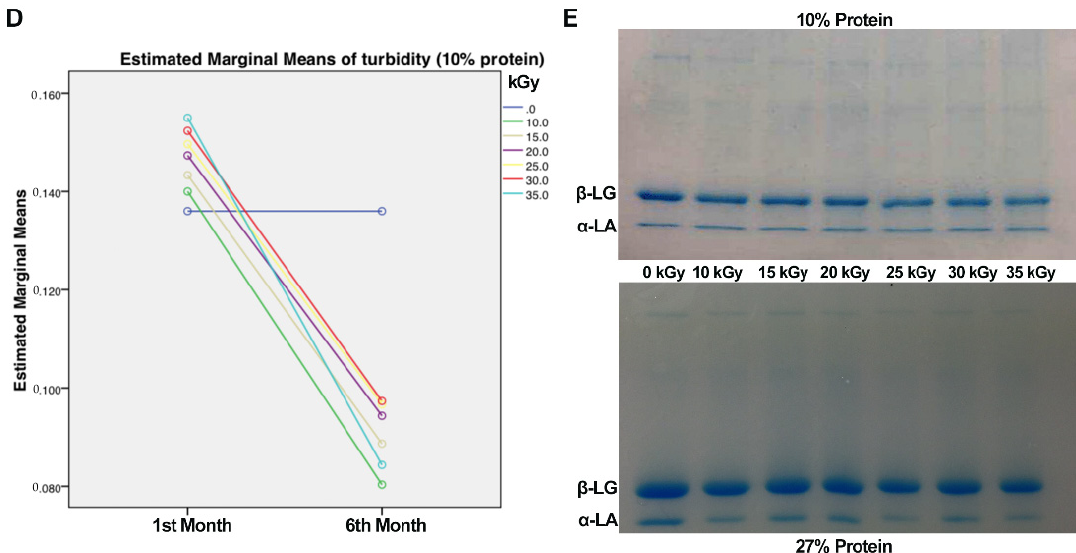
Figure 2. Effects of gamma radiation on property changes of WPI solutions (10% protein). ( A ) Effect of gamma radiation on soluble nitrogen of WPI solution (10%) in the first month after gamma radiation. ( B ) Comparison of estimated marginal means of turbidity of WPI solution from 0 kGy to 35 kGy gamma radiation in first month and sixth month. ( C ) Comparison of estimated marginal means of turbidity of WPI solution from first month to sixth month treated by gamma radiation (0–35 kGy). ( D ) Estimated marginal means of turbidity (10% protein) between first month and sixth month after gamma radiation 0. ( E ) Whey protein profiles before and after radiation at different dosages (10–25 kGy) of 10% and 27% WPI solutions.